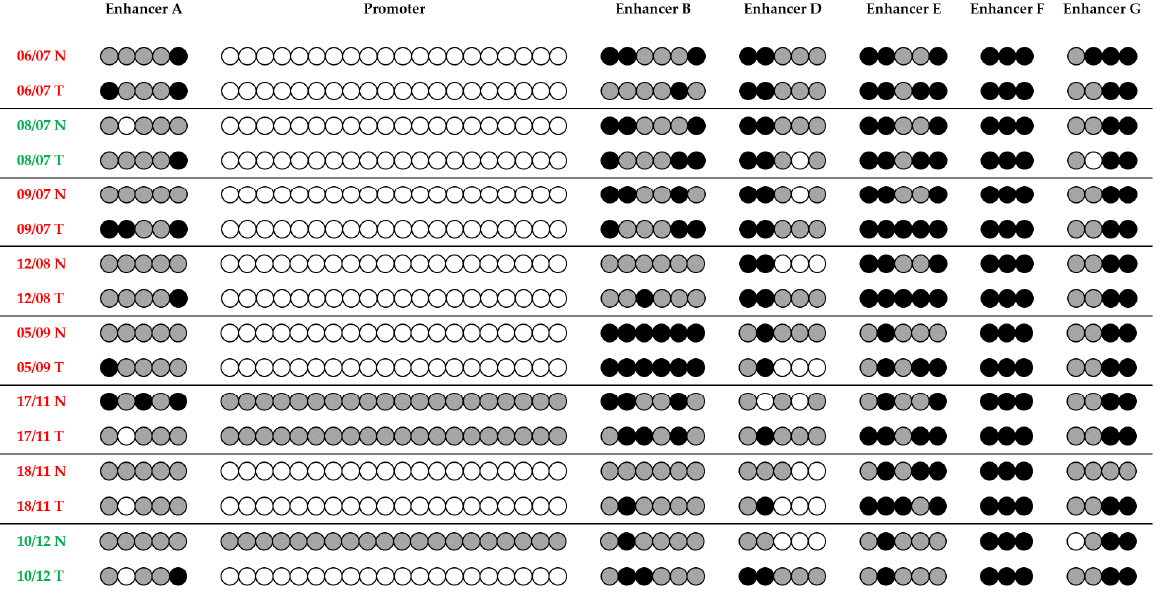
Figure 3. Methylation analysis of CDH1 promoter and enhancers on a selection of DNA samples from peripheral blood of three healthy individuals (in blue) and nine HDGC CDH1 -negative patients (six DGC patients in black and three LBC patients in violet). The complete case series is reported in Supplementary Figures S1 and S2. non-methylated CpG site; partially methylated CpG site; fully methylated CpG site.